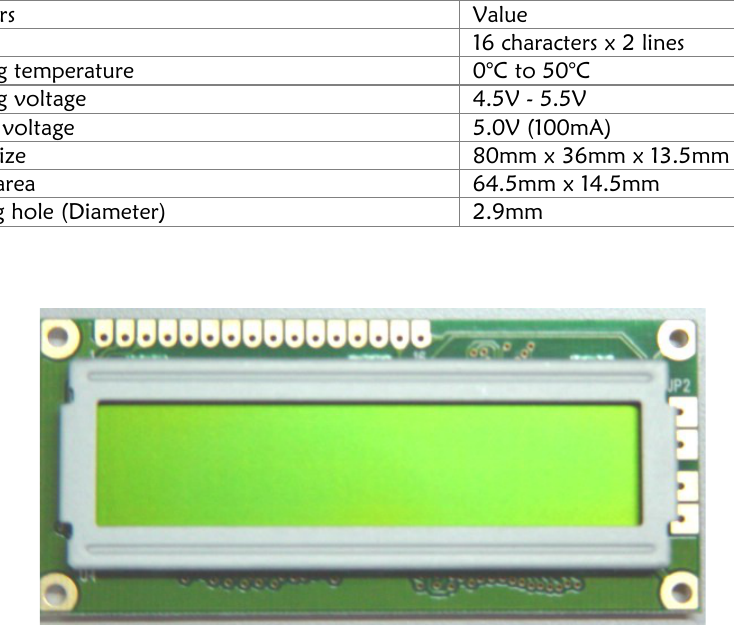
Figure 8: 2X16 LCD